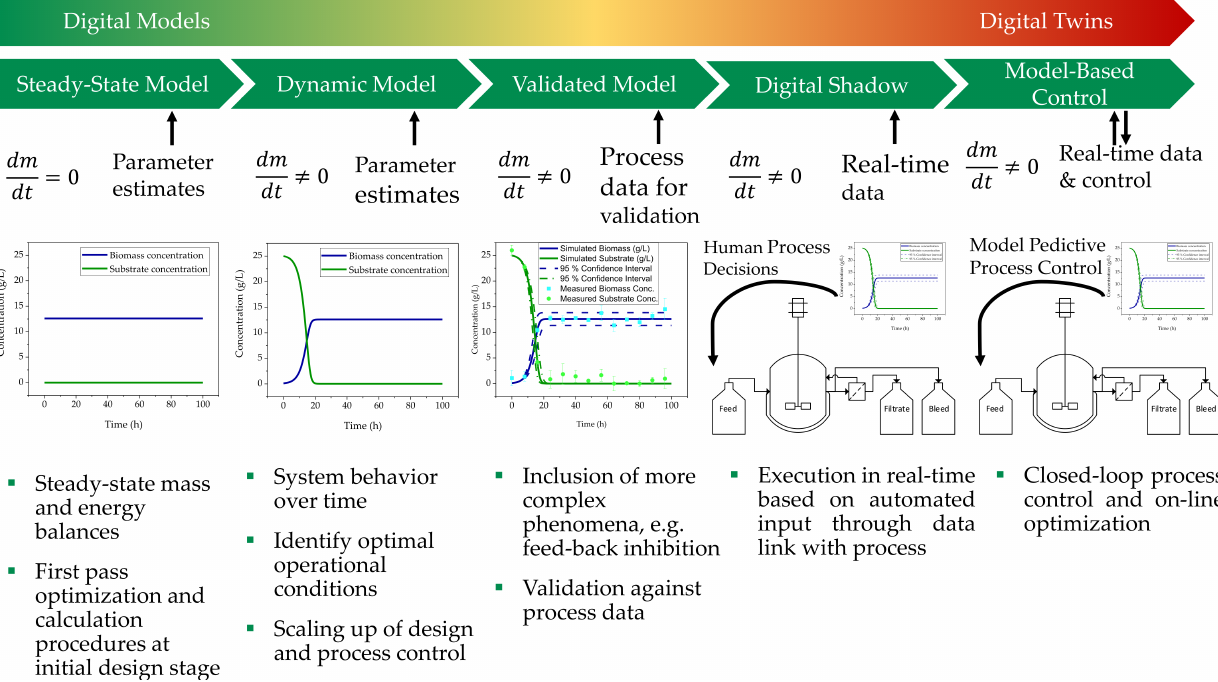
Figure 1. Levels of a Digital Twin, Starting from a Steady-State-Model, over a Dynamic Model, a Validated Model and a Digital Shadow to a Model-Based Control